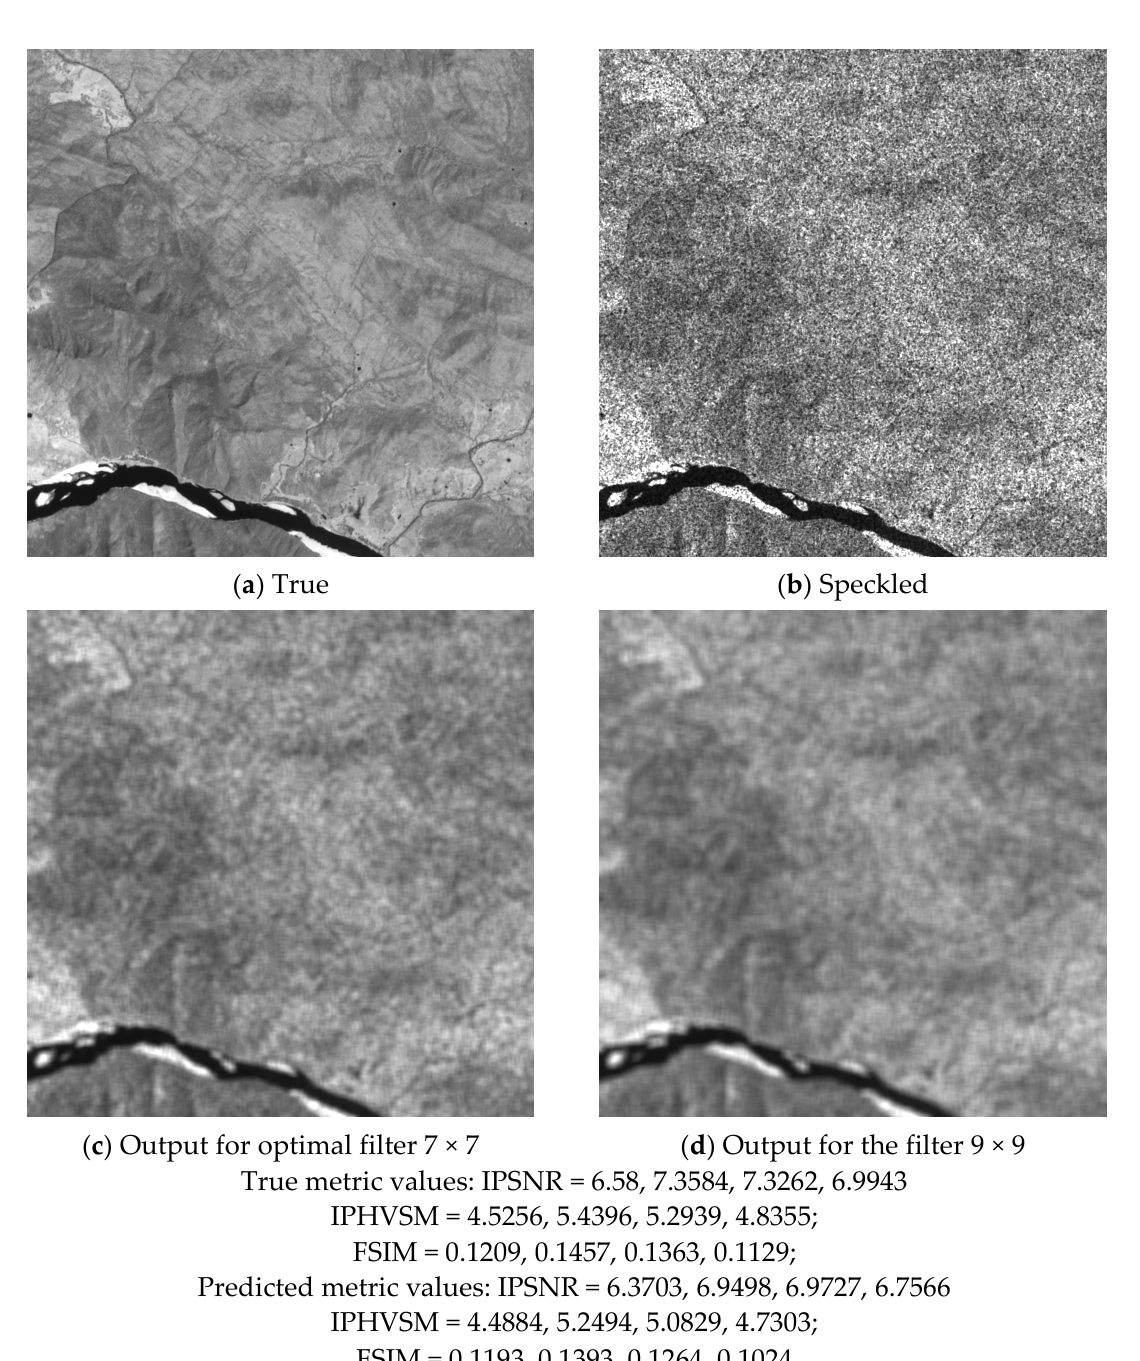
Figure 18. The true image ( a ); the speckled image ( b ); the optimal filter output for the 7 × 7 scanning window ( c ); and the filter output for the 9 × 9 scanning window ( d ).